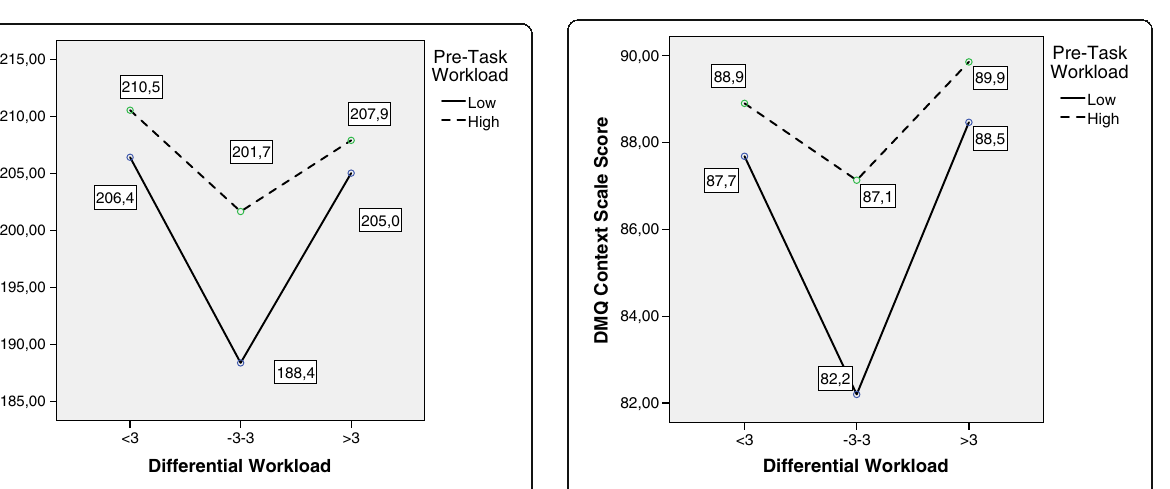
Fig. 5 MANOVA. Estimated marginal means. Differential Workload vs. Decision-Making Questionnaire Task scale. DMQ Decision-Making